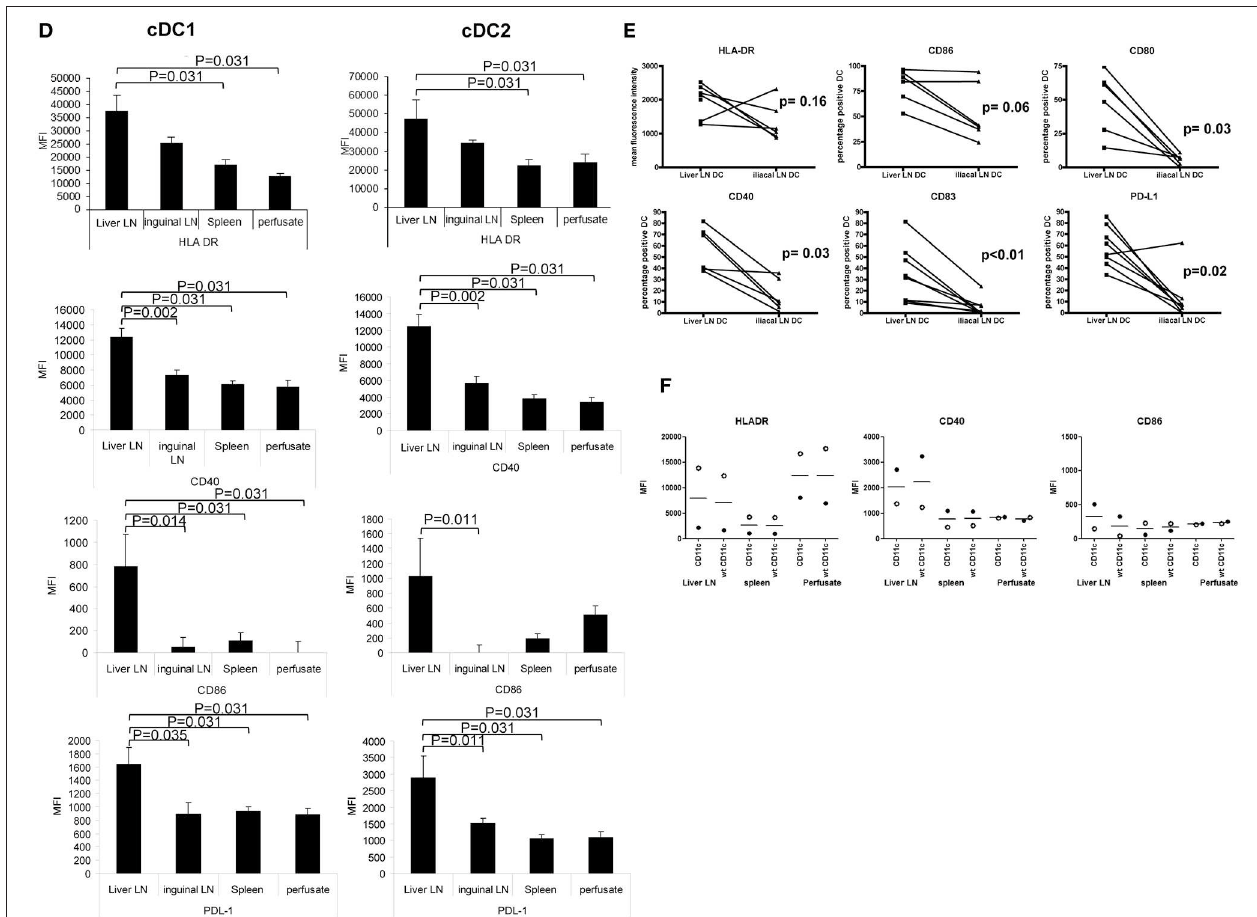
FIGURE 2 | Relative cDC subset numbers and their maturation status in hepatic and inguinal lymph nodes, spleen and liver. (A) The proportions of lineage − CD141 bright cDC1 and lineage − CD11c + CD1c + cDC1were determined within CD45 + MNC. Dead cells were excluded from the analysis by excluding 7AAD + cells. Dots represent individual tissues, and lines indicate mean values. Hepatic LN, spleen tissues, and liver perfusates were obtained from the same multi-organ donors, while inguinal LN were collected from kidney transplant recipients. (B) Histograms showing expression of HLA DR, CD40, CD86, and PDL-1 on lineage − CD141 bright cDC1 from hepatic lymph nodes, inguinal lymph nodes, spleen, and liver. Light gray histograms are isotype control stains. (C) Histograms showing expression of HLA DR, CD40, CD86, and PDL-1 on lineage − CD1c + cDC2 in hepatic lymph nodes, inguinal lymph nodes, spleen, and liver. Light gray histograms are isotype control stains. (D) Summary of expression levels (MFI) of HLA DR, CD40, CD86, and PDL-1 on lineage − CD141 bright cDC1 and lineage − CD1c + cDC2 in liver LN ( n = 6) and inguinal lymph nodes ( n = 7), spleen ( n = 6) and liver ( n = 6). Data are depicted as means ± SEM. (E) Expression